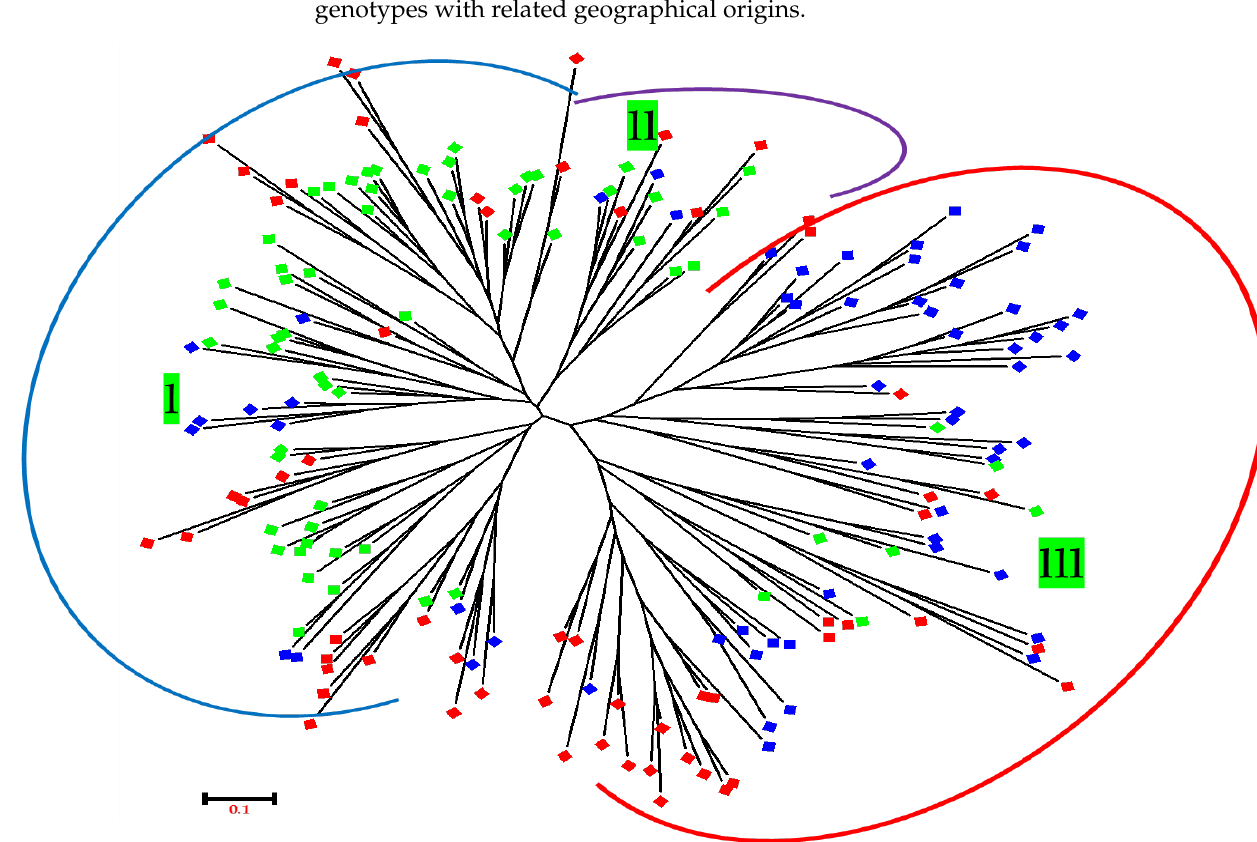
Figure 6. Neighbor-joining (N-J) phylogenetic represented genetic relationship among the Z. num- mularia genotypes collected from different geographical regions of KP, Pakistan. Note: Red was des- ignated for District Swat, green was designated for District Dir (L), and blue was designated for District Buner.